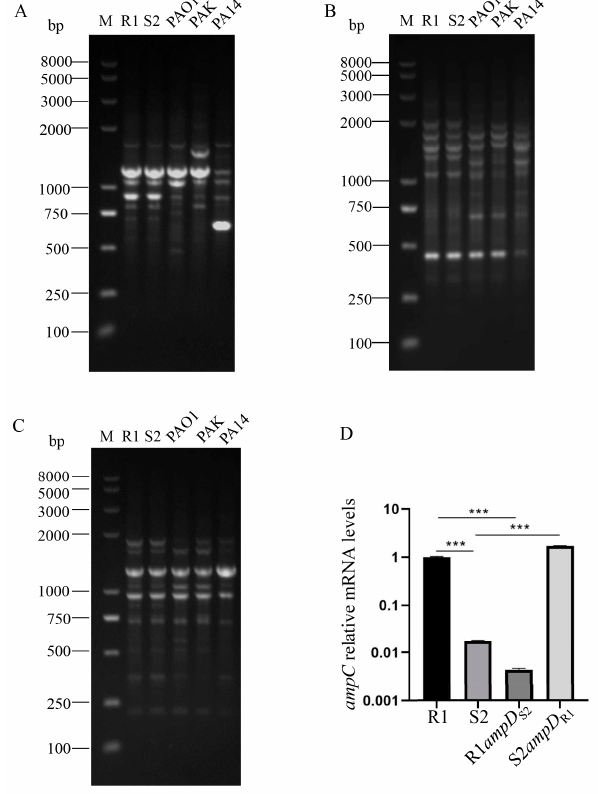
Figure 1. ( A – C ) RAPD typing of strains R1 and S2 using primers 272 ( A ), 208 ( B ), and 241 ( C ), M: Marker; ( D ) Relative ampC mRNA levels in the indicated bacterial strains. Total RNA was purified from the indicated strains at an OD 600 of 1.0, and the relative mRNA levels of the ampC gene were determined by real-time qPCR using rpsL as an internal control, ***, p < 0.001, by Student’s t test.